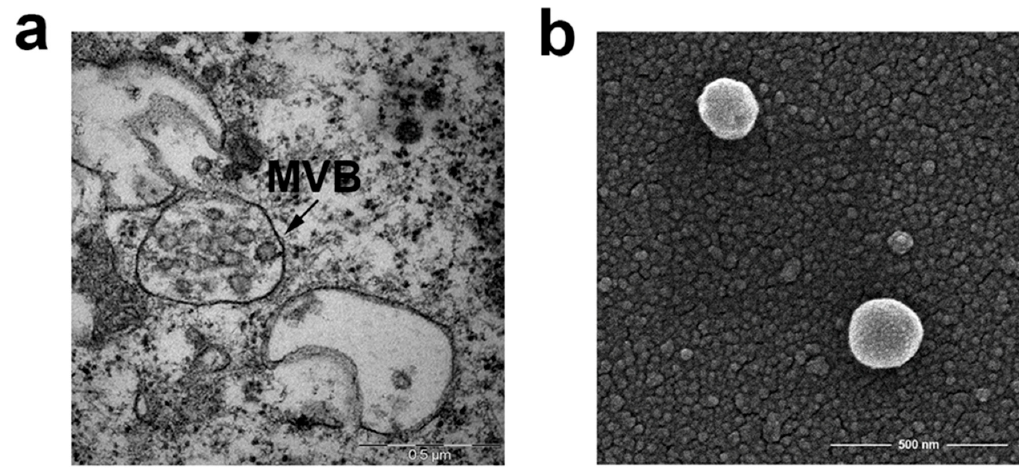
Figure 1. Electron microscopy of multivesicular bodies (MVB) and small extracellular vesicles (sEVs) ( a ) TEM micrograph of multivesicular bodies with intraluminal vesicles in Mel501, a melanoma cell line ( b ) SEM (Scanning Electron Microscope). Micrograph of sEVs purified from conditioned medium of Mel501 cells by di ff erential centrifugations. Courtesy of Francesca Iosi and the Microscopy Area of the ISS Core Facilities.